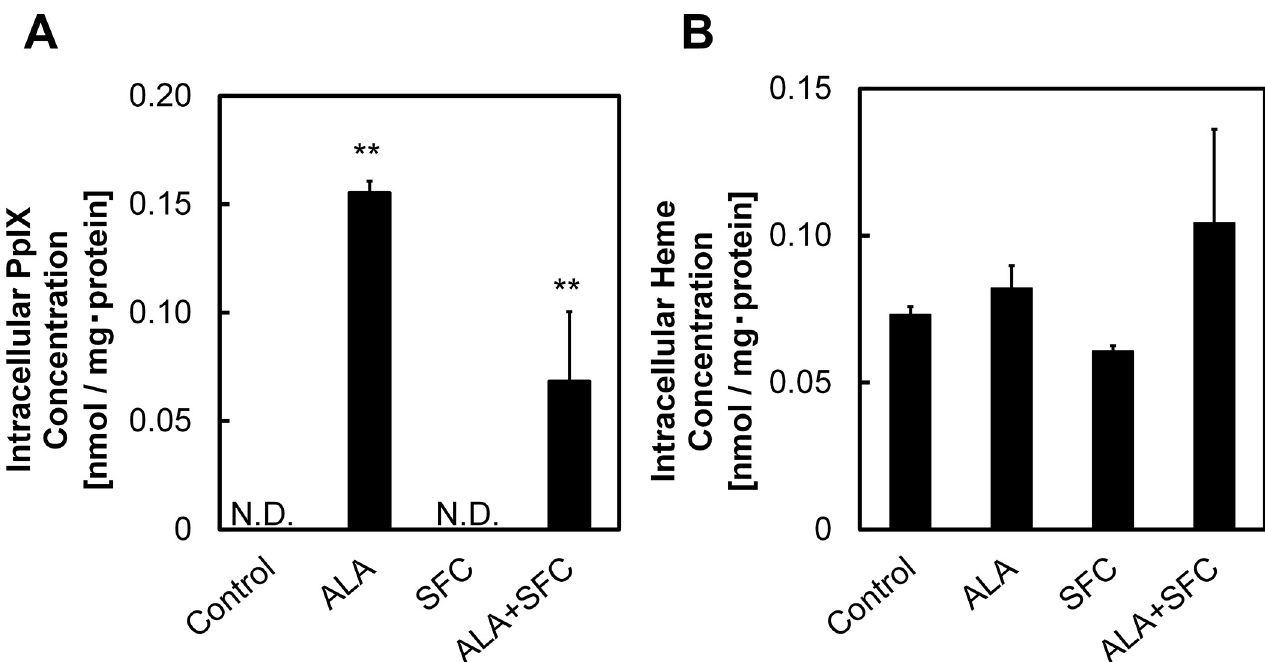
Fig 5. Changes of PpIX and heme production following co-administration of ALA and SFC in VeroE6 cells. Concentration of intracellular (A) PpIX and (B) heme in VeroE6 cells following administration of ALA and SFC. A one-way ANOVA (Tukey’s test) was performed for each data set to identify differences in mean values between treated and untreated samples; �� , p < 0.01. n = 3. Bars represent standard deviation (SD). Blots are cropped to ease visualization.